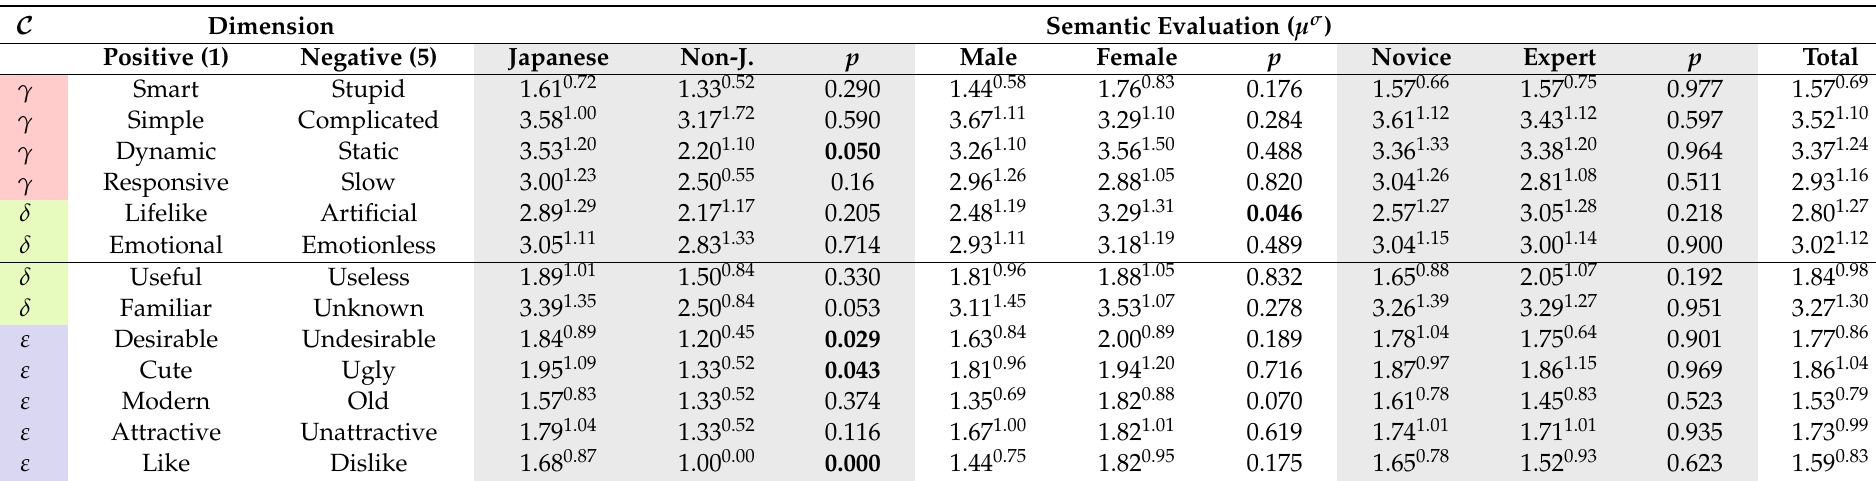
Table 3. Semantic analysis results (K-2). The concepts ( C ) are regarding to the behavior ( γ ), interactions ( δ ) and appearance ( ε